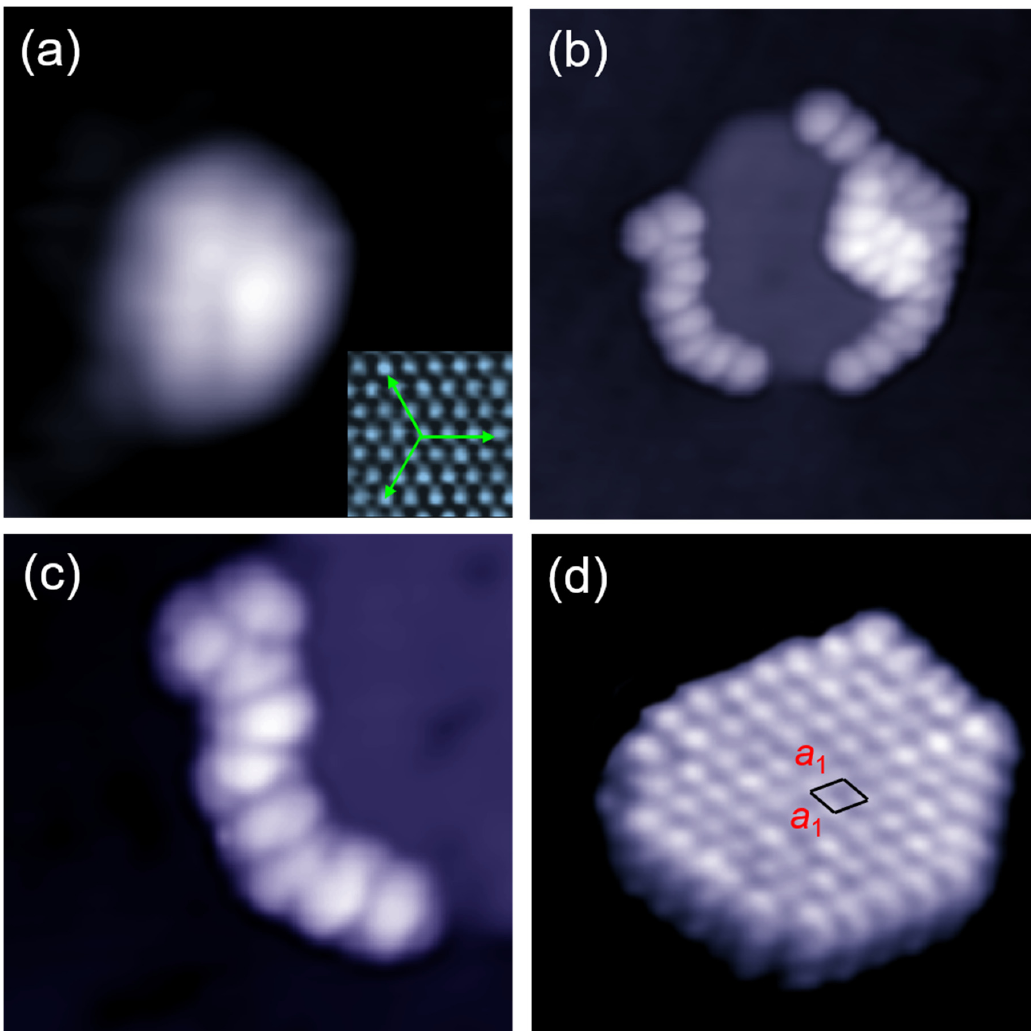
Figure 1. Initial stage of the self-assembly of C 60 molecules on Cd (0001). ( a ) STM image of an isolated C 60 molecule on Cd(0001), 4.5 nm × 4.5 nm, 1.0 V, 28 pA. Inset is the hexagonal lattices of the Cd(0001) thin film grown on the Si(111)-7 × 7 surface, 2 nm × 2 nm, − 0.05 V, 35 pA. ( b ) Step decoration of C 60 molecules to a round Cd island, 20 nm × 20 nm, 1.7 V, 25 pA. ( c ) Close-up view of the C 60 chain attaching to the edge of Cd island, 10 nm × 10 nm, 0.5 V, 25 pA. ( d ) A monolayer island of C 60 formed on the Cd substrate, 15.7 nm × 15.7 nm, 2.2 V, 28 pA.